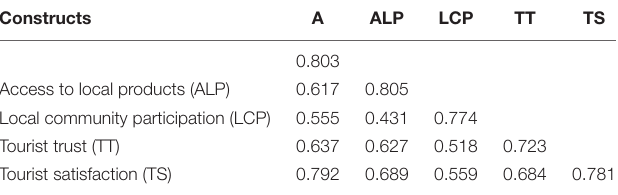
TABLE 2 | Sample characteristic ( N = 644). TABLE 3 | Discriminant